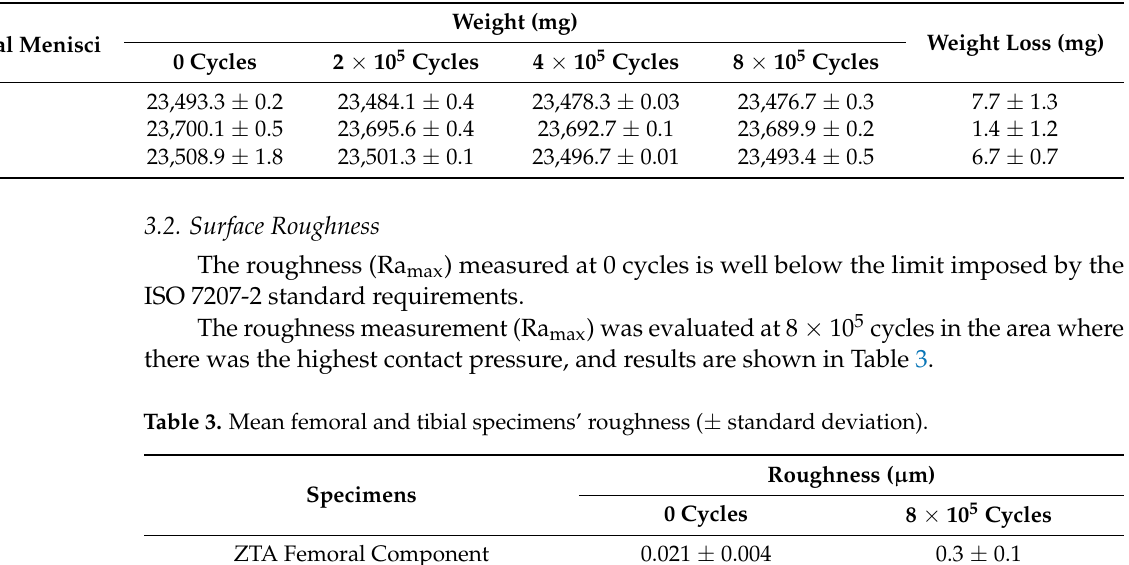
Table 2. Mean weight and weight loss ( ± standard deviation) of tibial menisci.